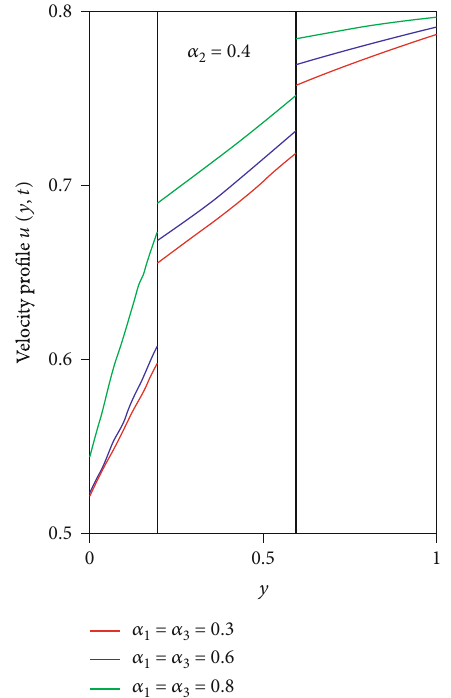
Figure 12: Velocity pro fi les u multilayer Maxwell fl uid at t = 0 : 19, λ and di ff erent values of fractional parameters α